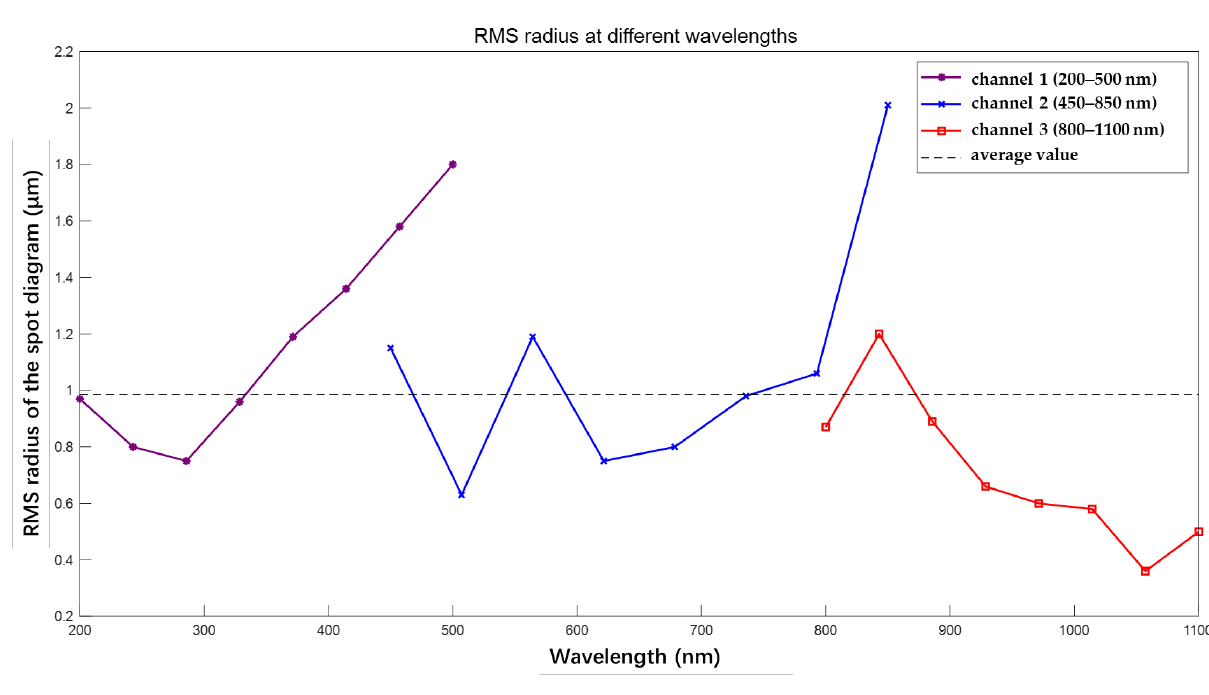
Figure 9. The curve of each spot size in Figure 8.